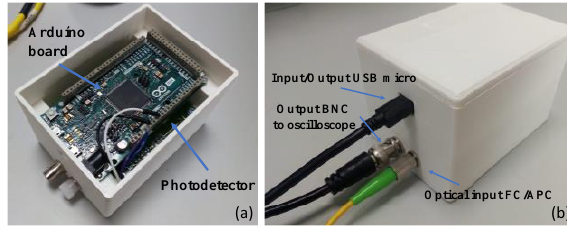
Fig. 4. (a) Inside and (b) outside picture of the data acquisition boards that compose the interrogator.